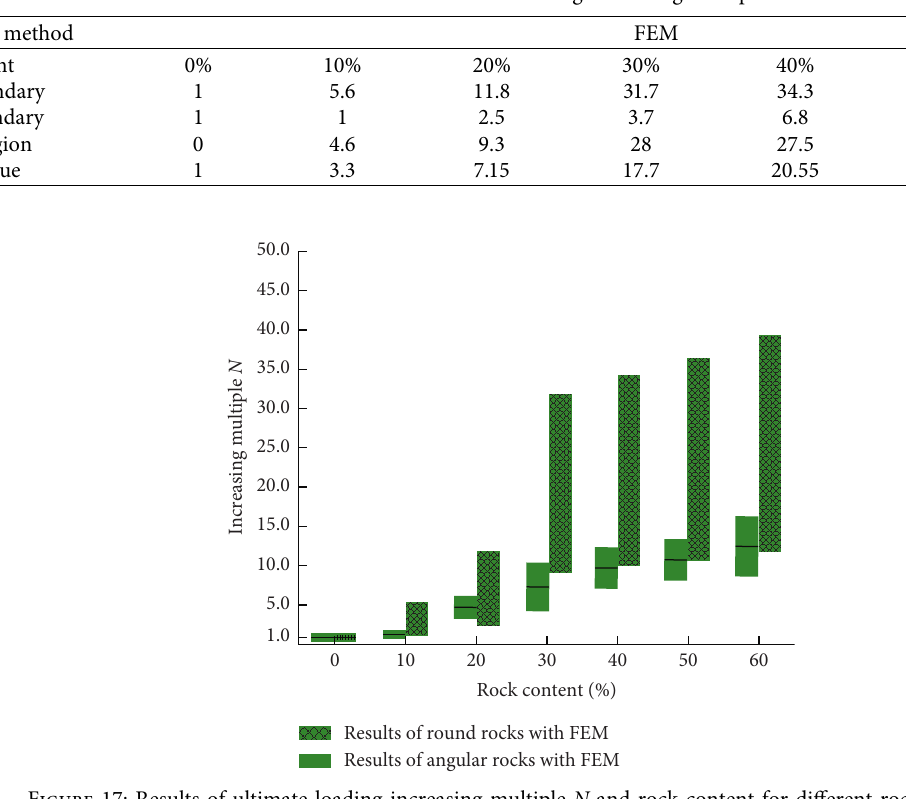
Figure 16: Results of ultimate loading increasing multiple N and rock content. Table 4: Results of ultimate loading increasing multiple.